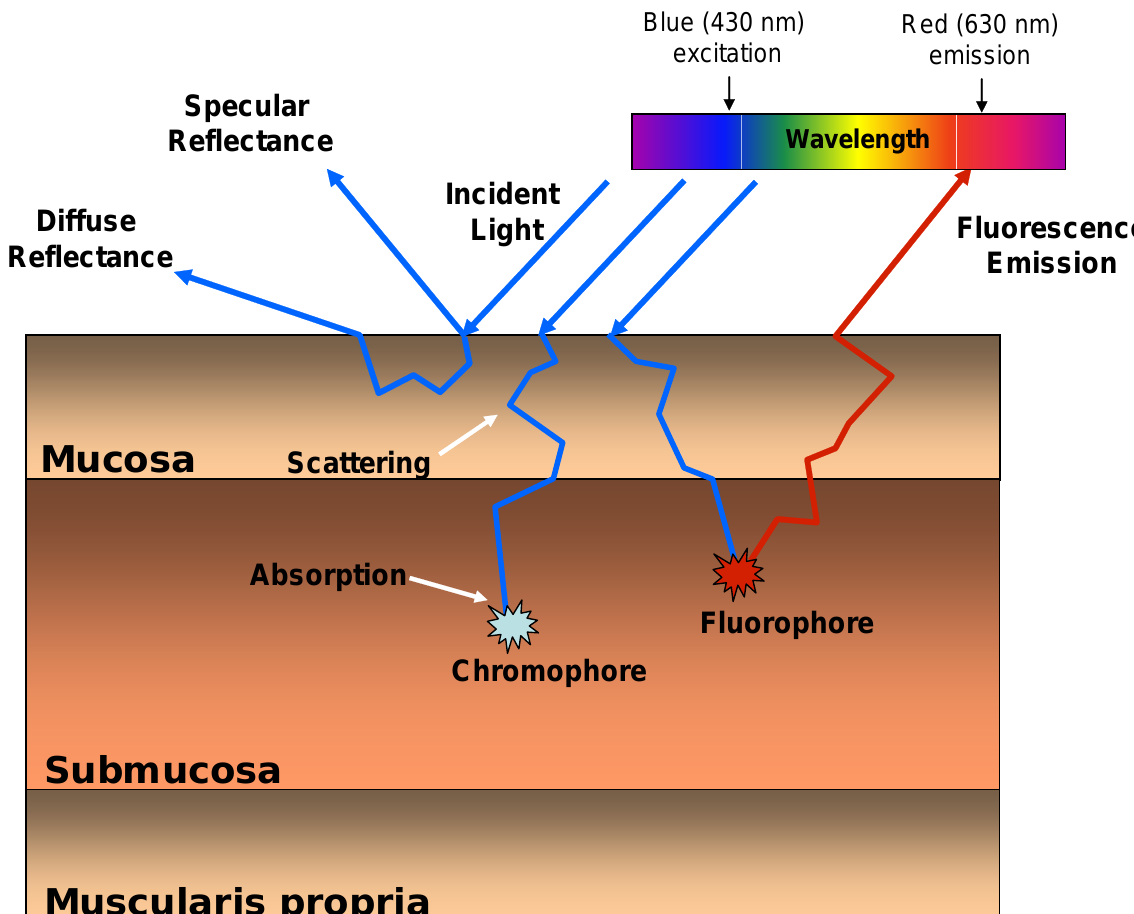
FIGURE 1 . Schematic diagram illustrating various light-tissue